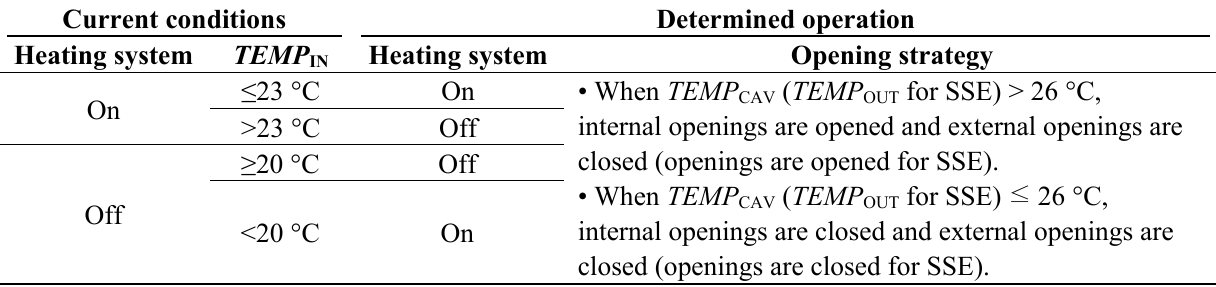
Table 4. Control algorithm of conventional non-ANN-based temperature control